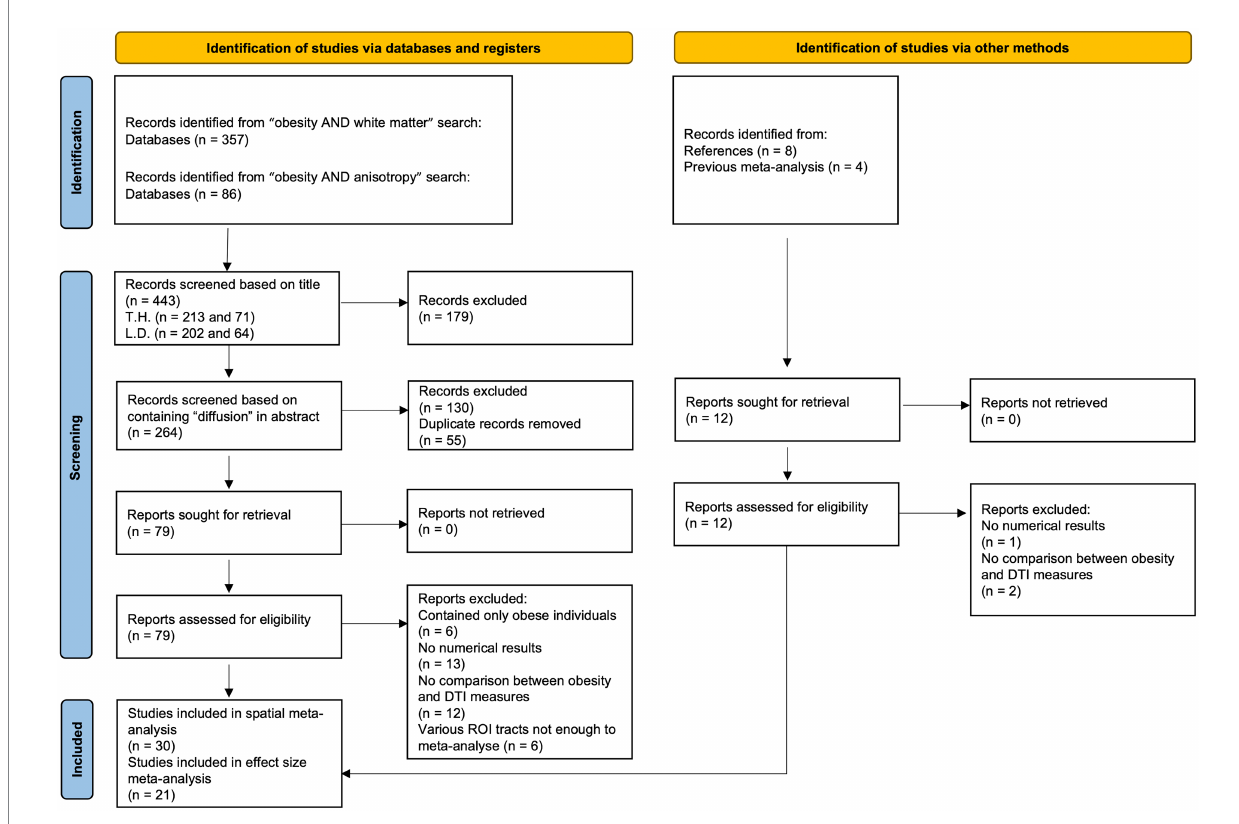
FIGURE 1 Study selection flow chart. Template adapted from Page et al.